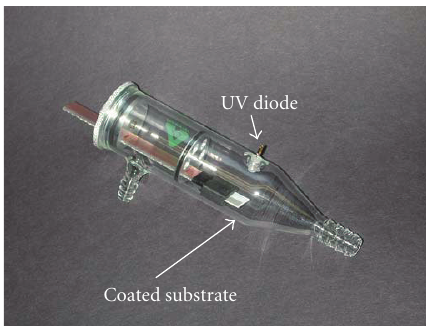
Figure 1: 100 mL reactor with two access ports, UV diode, and electrode-connected substrate